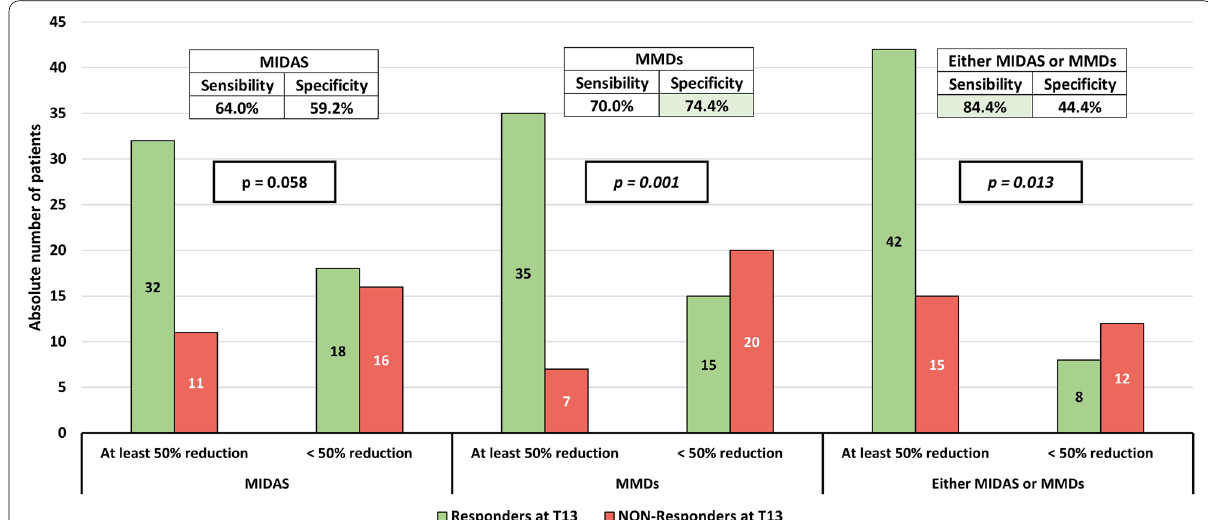
Fig. 4 Distribution of Responders T13 according to MIDAS and MMDs reductions after 3 months of erenumab administration. MIDAS: MIgraine Disability Assessment. MMDs: monthly migraine days. Responders T13 : patients with a MMDs reduction from baseline of at least 50% in the last 4 weeks of observation period (after 13 erenumab administrations). The p-value in the box was calculated with a χ 2 test. The tables in the top of the figure show the sensibility and specificity of being Responders T13 according to reduction of at least 50% in MIDAS, MMDs, or " either MIDAS or MMDs". The green shadows in the tables highlight the parameters with the best accuracy in sensibility or